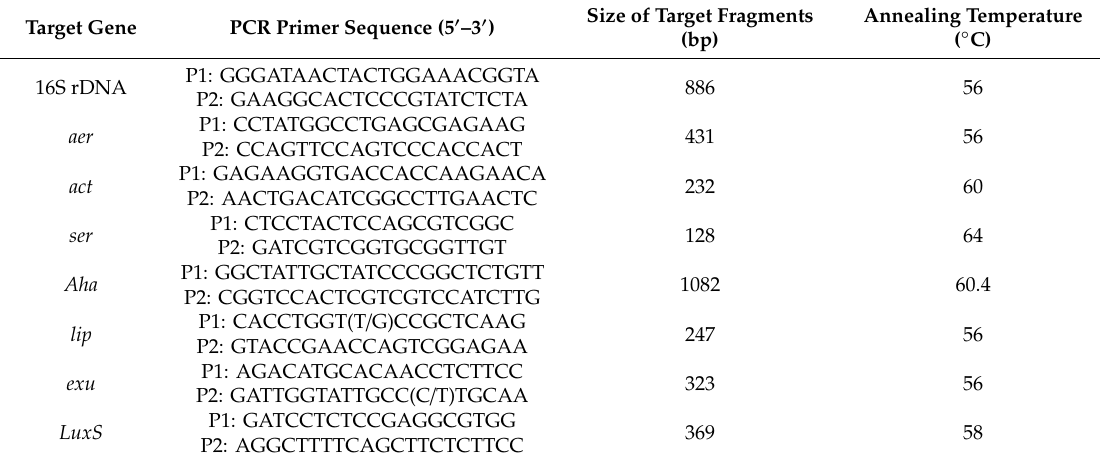
Table 3. Polymerase chain reaction (PCR) primers and target fragment